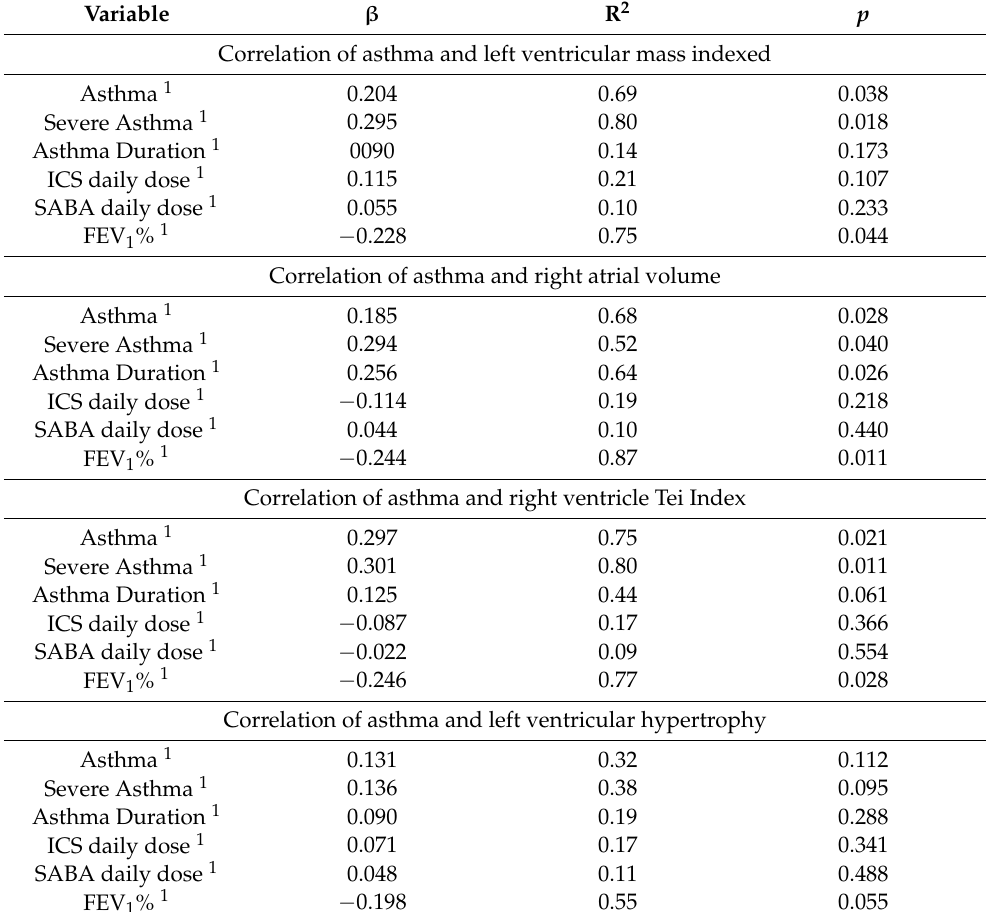
Table 3. Multivariate regression